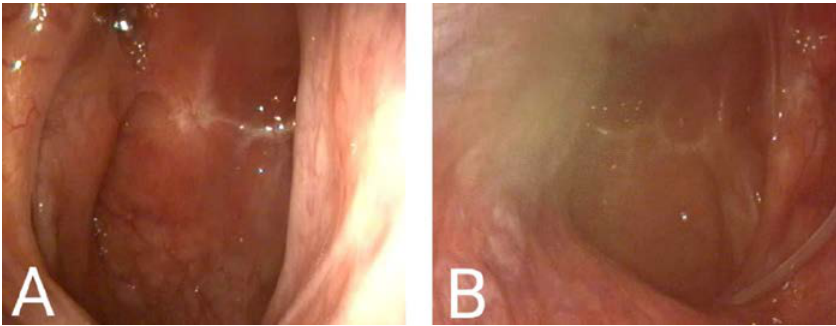
Figure 5. Videoendoscopic examination showing ( A ) right and ( B ) left permeable choana.